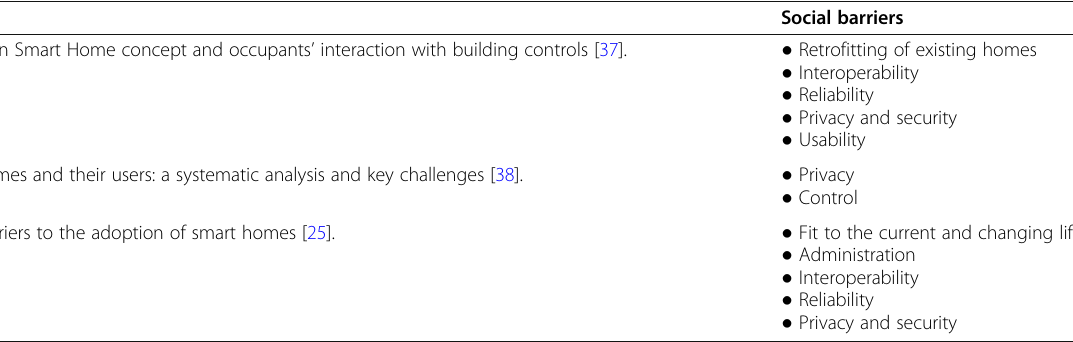
Table 6 Social barriers presented in articles